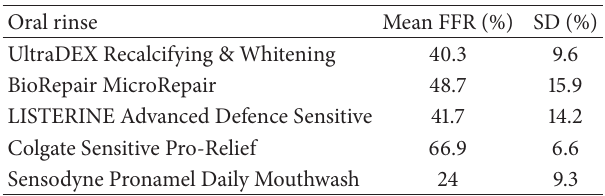
Table 1: Fluid flow reduction measurements for the test and control oral rinses ( 𝑛 = 5